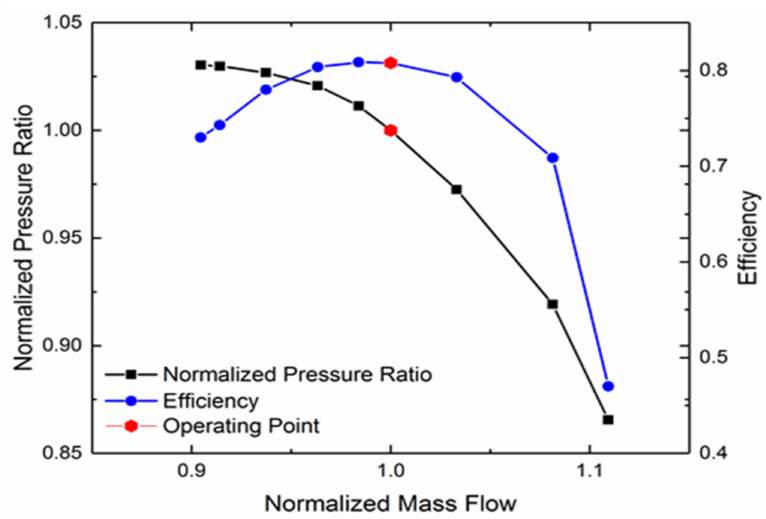
Figure 9. Performance map for the multistage compressor.